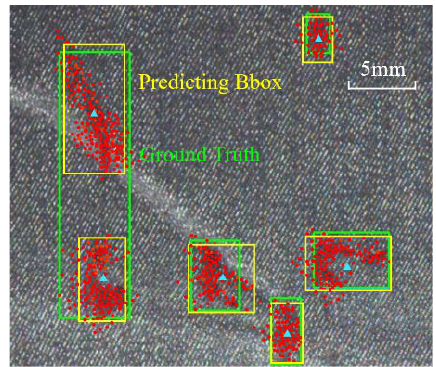
Figure 7. Effective receptive field from deformable extraction in guided localization.